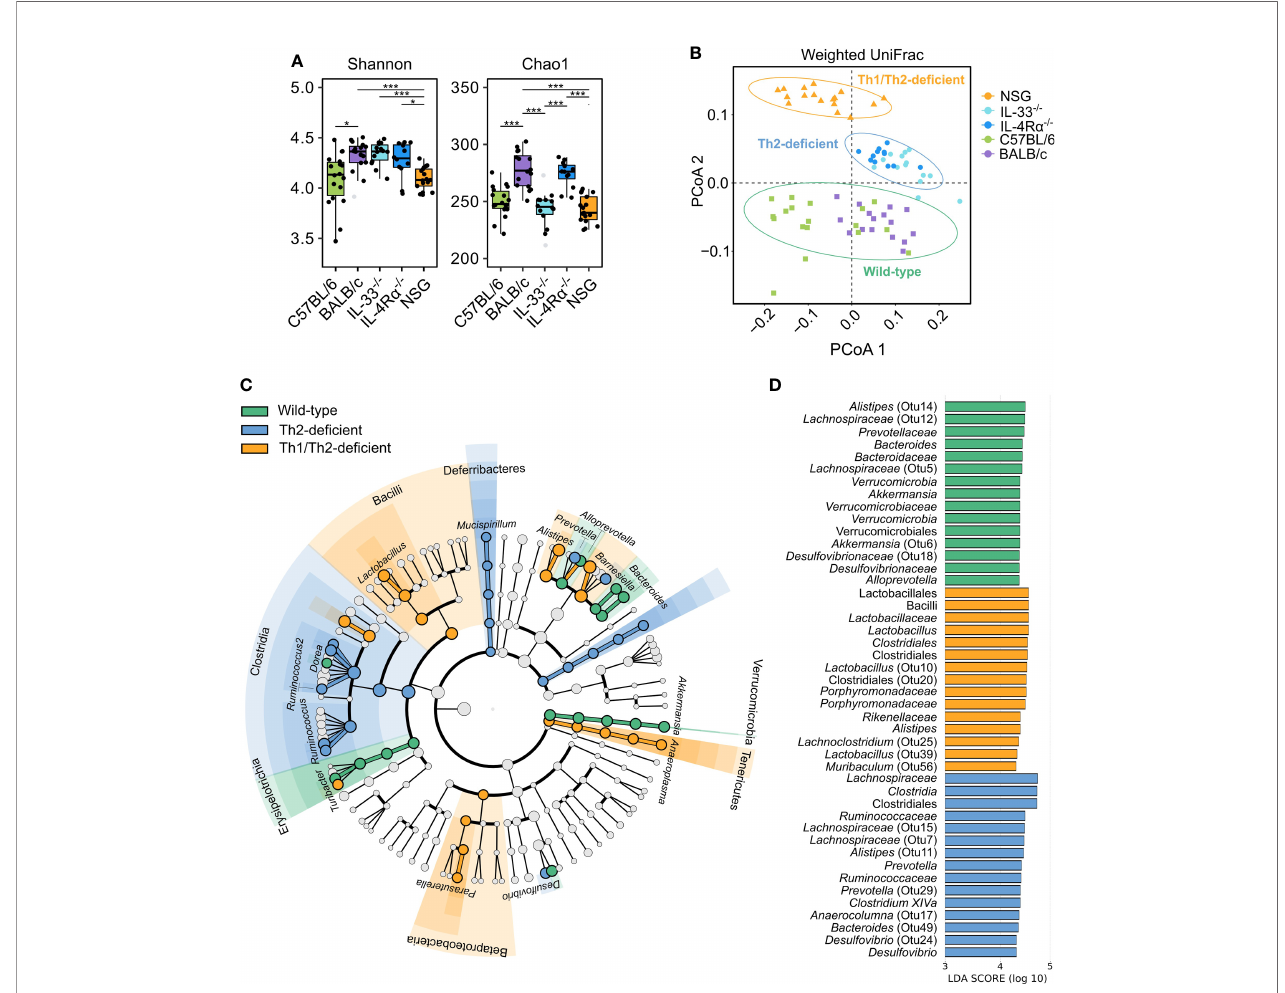
FIGURE 4 | Unsupervised clustering showed three distinct microbial community types that distinguish wild-type from Th2- and Th1/Th2-de fi cient animals. 16S rRNA gene pro fi ling was used to study the caecal microbiota composition in naïve, SPF-housed, wild-type C57BL/6 (green, n = 18) and BALB/c (purple, n = 16), Th2-de fi cient BALB/c IL-33 -/- (light blue, n = 14) and IL-4R a -/- (blue, n = 12), and Th1/Th2-de fi cient NSG (orange, n = 17) animals. (A) Alpha diversity described by the Shannon and Chao1 diversity indices was compared using the two-sided non-parametric Wilcoxon rank sum test followed by Bonferroni correction of P -values, revealing a comparable overall diversity between all BALB/c animals (WT, IL-33 -/- and IL-4R a -/- ), whereas both NSG and C57BL/6 animals showed lower diversity due to decreased richness. (B) Differences in microbial composition were further assessed by conducting principal coordinate analysis (PCoA) and unsupervised clustering based on weighted UniFrac distances. Three primary clusters that correlated with the animals ’ immunocompetence were identi fi ed and are visualized by different shapes in the PCoA. (C) Differentially abundant OTUs between the three clusters were identi fi ed by linear discriminant analysis effect size (LEfSe, LDA > 3.0), which showed several taxa distinctly associated with each cluster as visualized in the cladogram. Bacterial class is shown with respective taxa at genus level. More detailed taxonomy is shown in supplement ( Supplementary Table 2 ). (D) The LDA values of the top 15 differentially abundant taxa associated with each group are visualized. Box plots indicate median (middle line), 25th, 75th percentiles (box), and 5th and 95th percentiles (whiskers) as well as outliers (single gray dots). Only signi fi cant comparisons between groups de fi ned by the clusters displayed in (B) are shown. SPF, speci fi c pathogen free; OTU, Operational taxonomic unit; LDA, linear discriminant analysis score; IQR, interquartile range; SD, standard deviation. * P < 0.05. *** P <